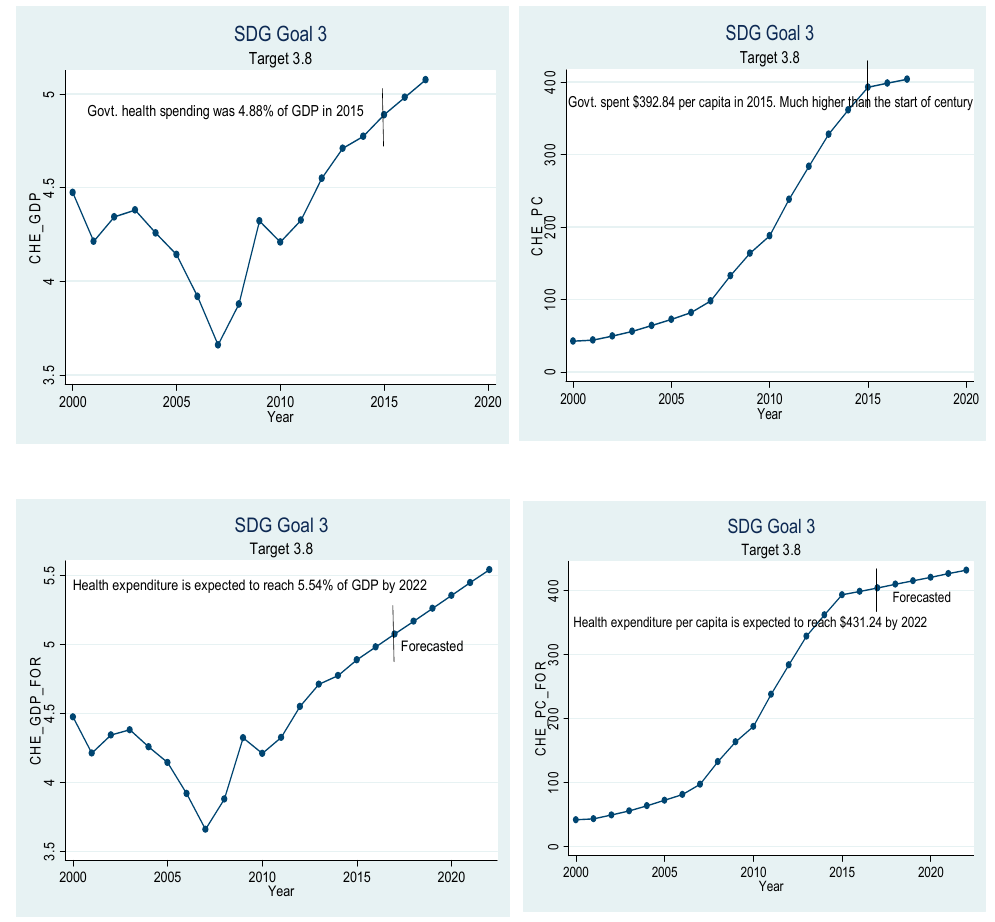
Figure 7. Sustainable development goal 3, target 3.8 (universal health coverage), ex-post and ex-ante .